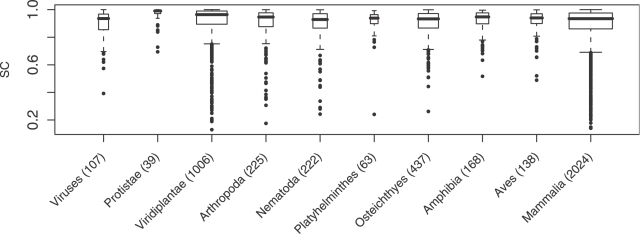
SC values for pre-miRNAs from various lineages.Box-and-whisker plots showing the self-containment index distribution among pre-miRNAs found in miRBase, indicating the median in bold, the interquartile range enclosed by the box, the smallest and largest non-outliers indicated by the whiskers, and outliers represented as individual points. The lineages displayed are, from left to right: viruses; protists; plants; and animals divided into the phyla arthropods, nematodes, flatworms, and chordates, which are further subdivided into classes/superclasses of fish, amphibians, birds, and mammals. Number of miRNAs for each lineage is shown in parentheses, and box width is proportional to the square root of this number.